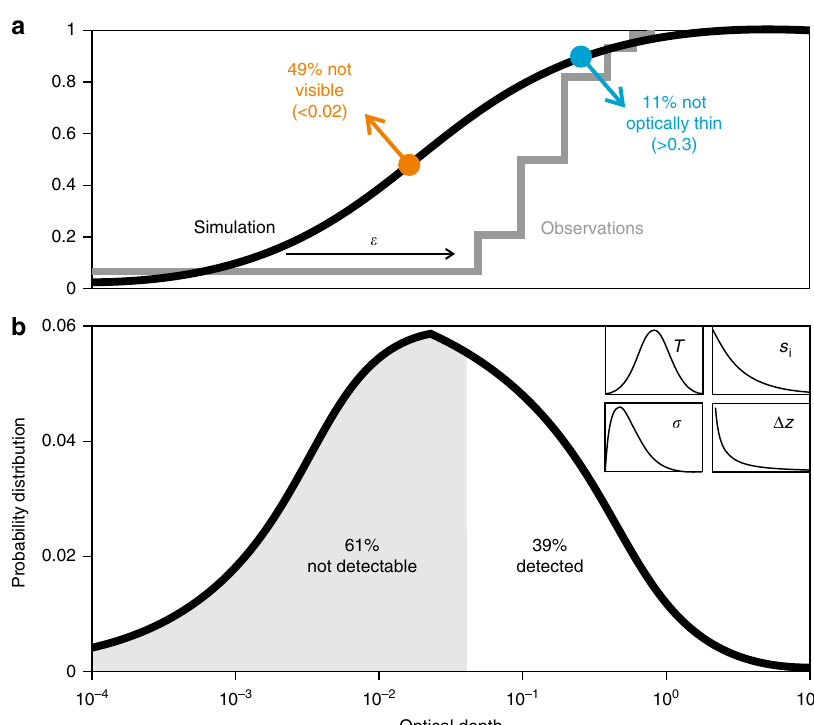
Fig. 6 Variability in contrail optical depth. Probability distributions (PDF) of contrail optical depth, OD, and (top) the cumulative distribution ( a ) simulated by an idealised contrail model. The model PDF ( b ) was obtained (i) by solving an equation governing the evolution of the ice crystal size distribution accounting for mixing-induced dilution, shear-induced spreading, sedimentation and growth by vapour uptake and (ii) by imposing on this solution variability in meteorological factors described by probability distributions (inset) of air temperature, T , ice supersaturation (accounting for unresolved vertical air motion variability), s i , vertical shear of horizontal winds, σ , and thickness of ice supersaturated layers, Δ z , all constrained by atmospheric observations and numerical weather analyses. Simulation results 65 are compared with satellite observations 56 of contrails over the eastern North Paci fi c in the year 2001. According to the model analysis 66 , the measurements detected only 39% of all contrails over the whole OD range, 49% are subvisible (OD < 0.02) and 11% are not optically thin (OD > 0.3). By comparing simulated and observed PDF, detection ef fi ciencies, ε , were inferred: 11.5% for data in the range 0< OD ≤ 0.05; 49% for 0.05 < OD ≤ 0.1; 94.5% for 0.1 < OD ≤ 0.2; and 100% for OD > 0.2, partly overlapping with values derived with other methods and in other conditions 59 . After adjusting the model PDF for inef fi cient detection using these ef fi ciencies (horizontal arrow), it replicates the observed cumulant (stepped curve). Overall, applying the detection ef fi ciency curve is consistent with a single cut-off OD value of 0.04, the upper limit OD value of the hatched area marking undetected (and partly invisible) contrails. The mean OD of all simulated contrails is 0.15, translating into 0.29 when corrected for non-detectable contrails. The corrected OD is roughly in line with the observed mean value, 0.24, that overestimates the model mean value of all contrails by ≈